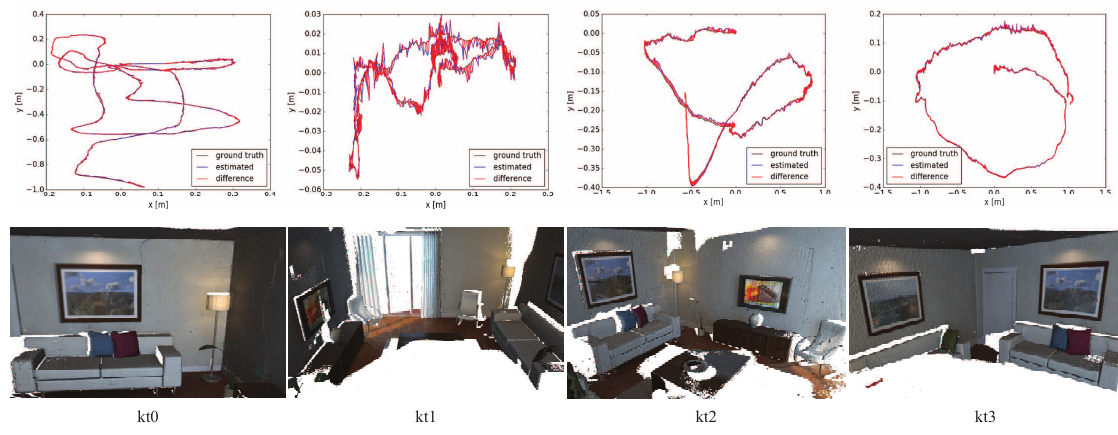
Figure 6. Reconstruction results with the proposed approach on ICL-NUIM living room sequences, the first row for estimated camera trajectories compared with the ground truth and the second row for surface reconstruction